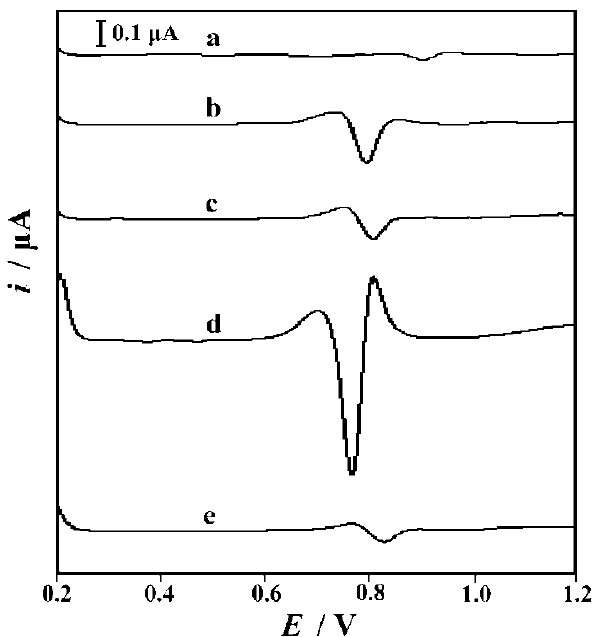
Figure 5. The second-order derivative linear sweep voltammograms of 0.1 mM Trp recorded at different electrodes: ( a ) CPE, (b) ABPE, (c) MIP/CPE, (d) MIP/ABPE and (e) NIP/ABPE in 0.1 M phosphate buffer (pH 7.0). Accumulation potential: − 0.1 V, Accmulation time: 60 s, scan rate: 0.1 V s − 1 .